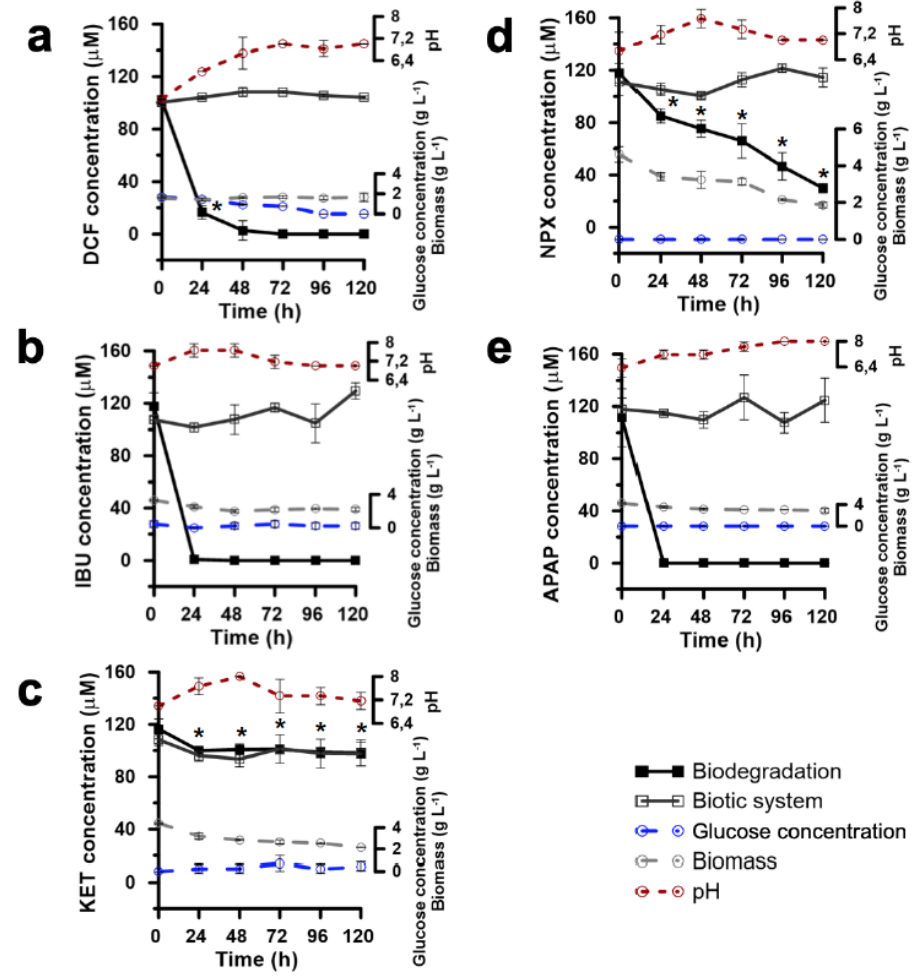
Figure 1. Individual degradation at flask-scale: pH and glucose concentration of the tested pharmaceutical compounds by Penicillium oxalicum in relation to biodegradation of the drugs. ( a ) Diclofenac (DFC); ( b ) ibuprofen (IBU); ( c ) ketoprofen (KET); ( d ) naproxen (NPX); and ( e ) acetaminophen (APAP). Biotic control corresponds to a heat-killed biomass control. The values are presented as the average of three independent experiments ± standard deviation ( n = 3). Asterisks (*) indicates statistical significance differences using Tukey ’s test ( p <